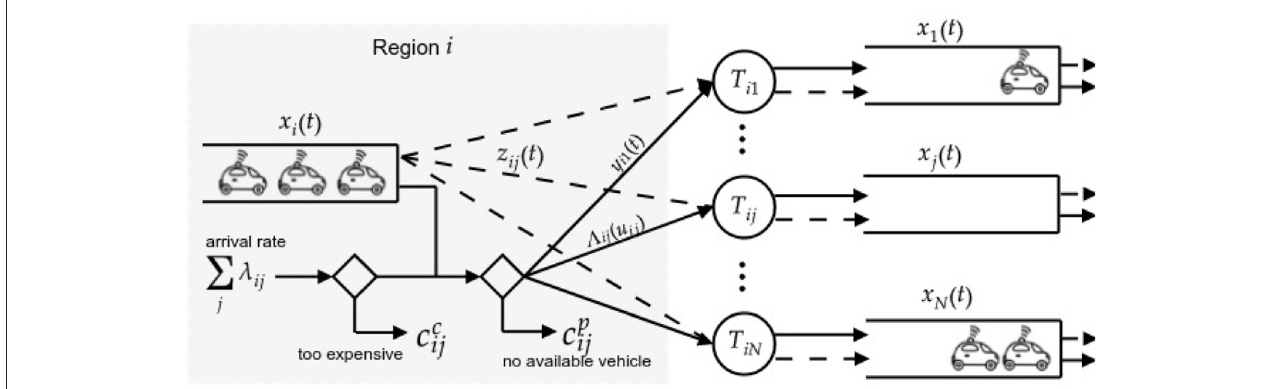
FIGURE 1 | Prospective customers wishing to travel from i to j arrive at a rate λ ij . Then, if they accept price u ij and there is an available vehicle they travel to j in T ij units of time. If the price u ij is above their willingness to pay, the MoD incurs a cost composed by the loss of a trip and a cost c c ij for disappointing the customer. Moreover, if the customer is willing to pay u ij but no vehicle in i is available, then the customer is rejected and the platform incurs a cost c p ij . The objective of the MoD provider is to plan a pricing policy u and a rebalancing policy r such that its profit (or other utility function) is